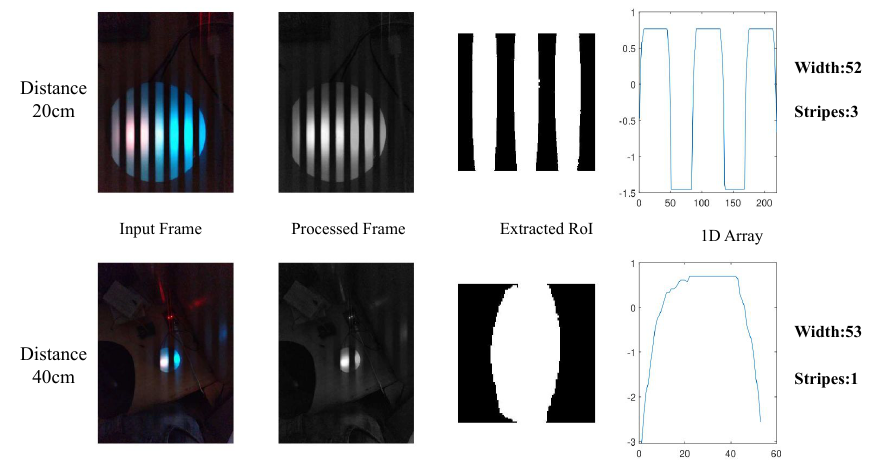
Figure 12. Number of Lines vs. width vs.